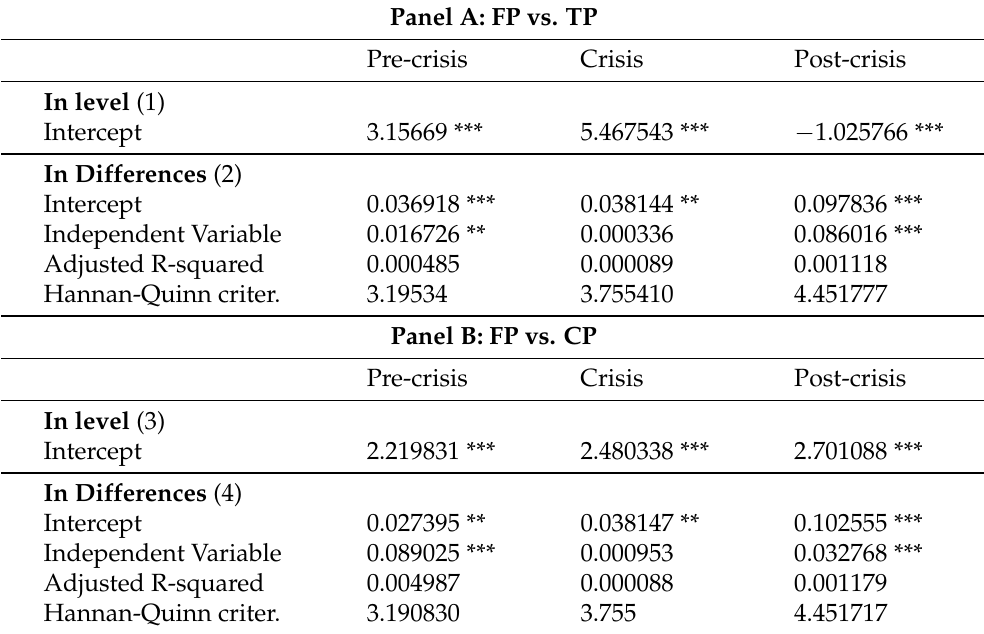
Figure 3. Company fixed effects. Table 4. Summary of subperiod panel regression